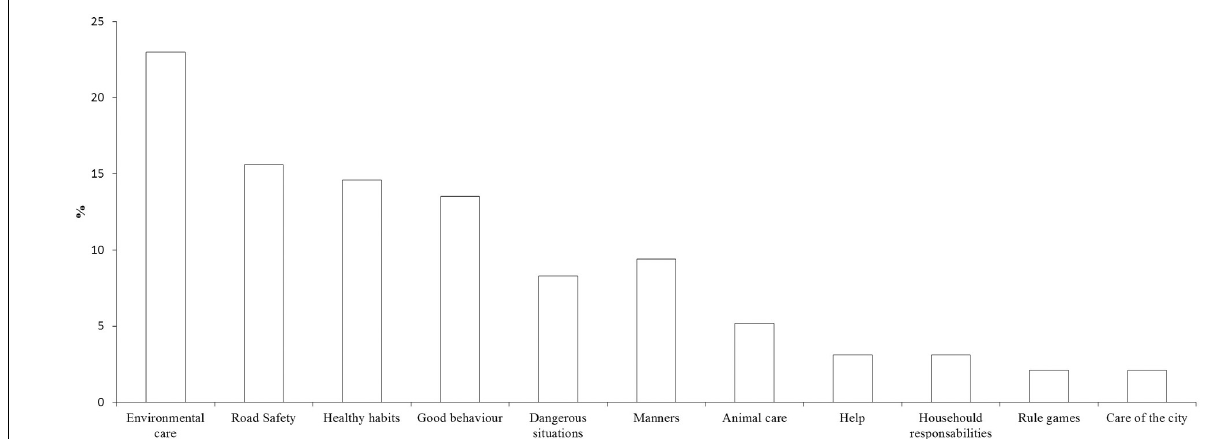
FIGURE 1 | Representation of teaching responsibilities.